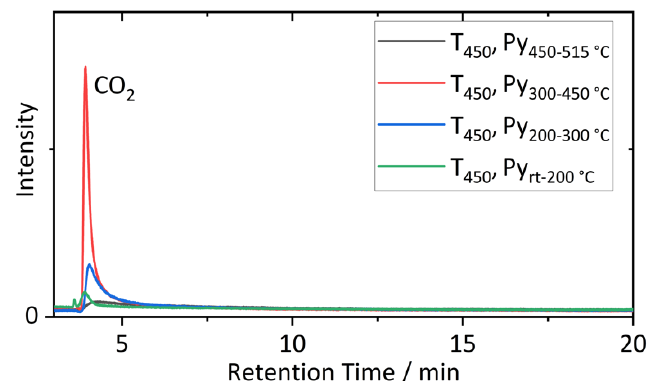
Figure 10. Magnified Py-GC-MS pyrograms of 4 different pyrolysis temperatures (200, 300, 450, and 515 °C) of the BM after roasting at 450 °C for 30 min. 515 ◦ C) of the BM after roasting at 450 ◦ C for 30 min.